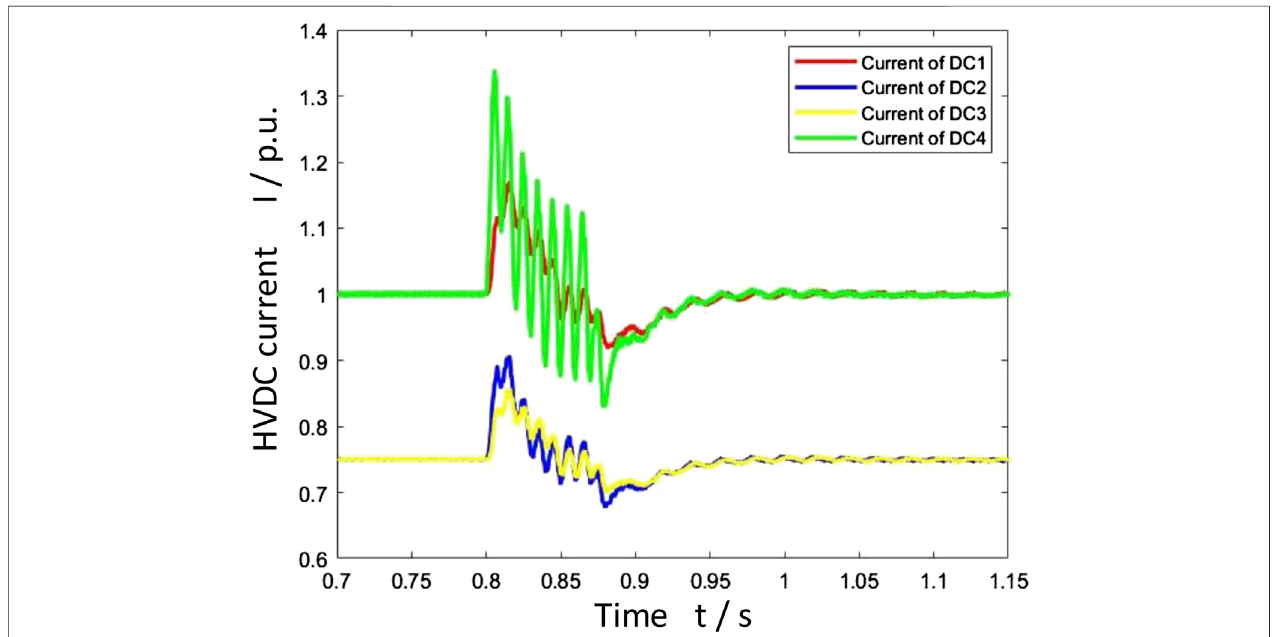
FIGURE 4 | Current of four HVDC